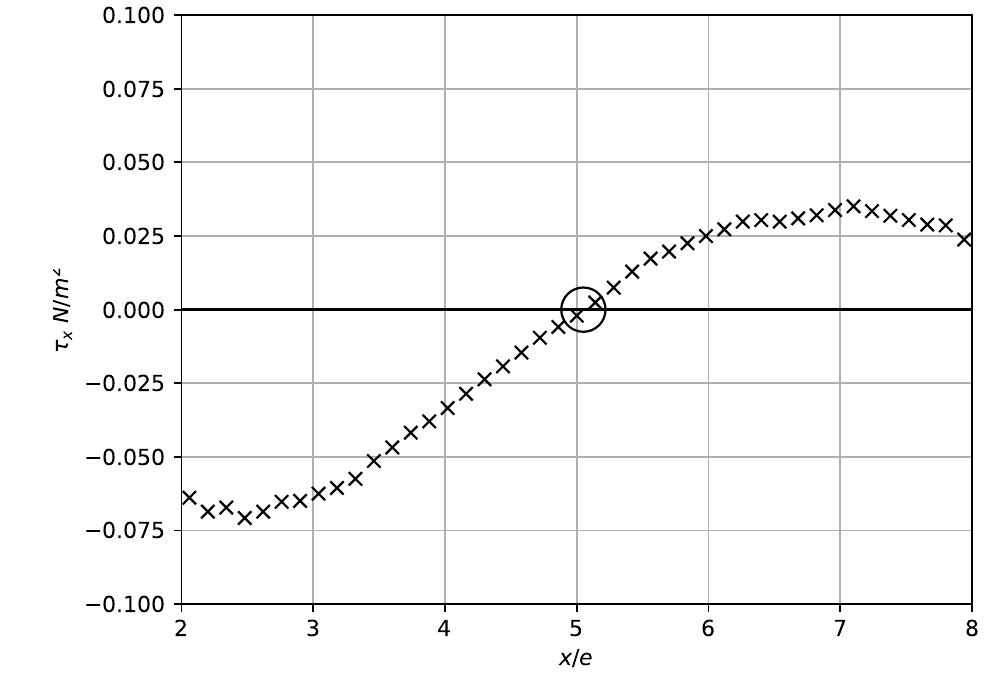
Figure 11. Representation of τ x to determine the reattachment point of the flow after detachment at the rib.